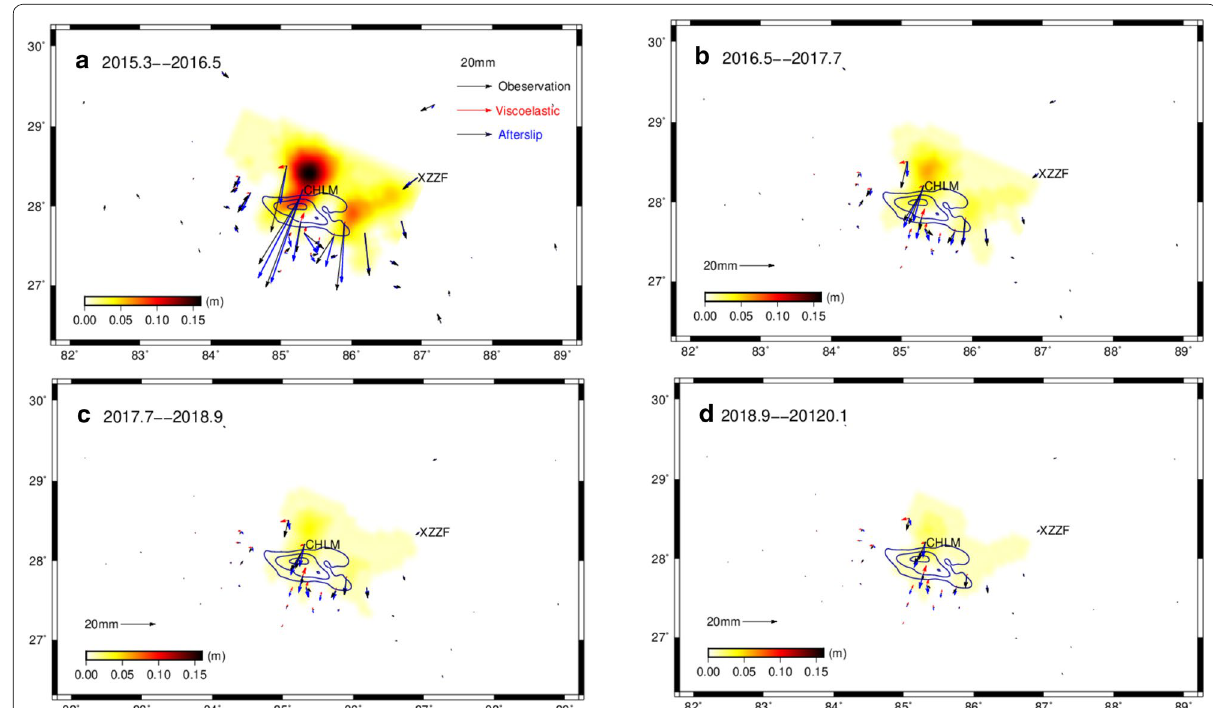
Fig. 7 Comparisons of observed and calculated displacements, including contributions from viscoelastic relaxation and afterslip during the different periods. Horizontal displacements are presented by arrows. The color inset in each panel shows horizontal residuals. The dark blue contours denote the coseismic slip distribution on the